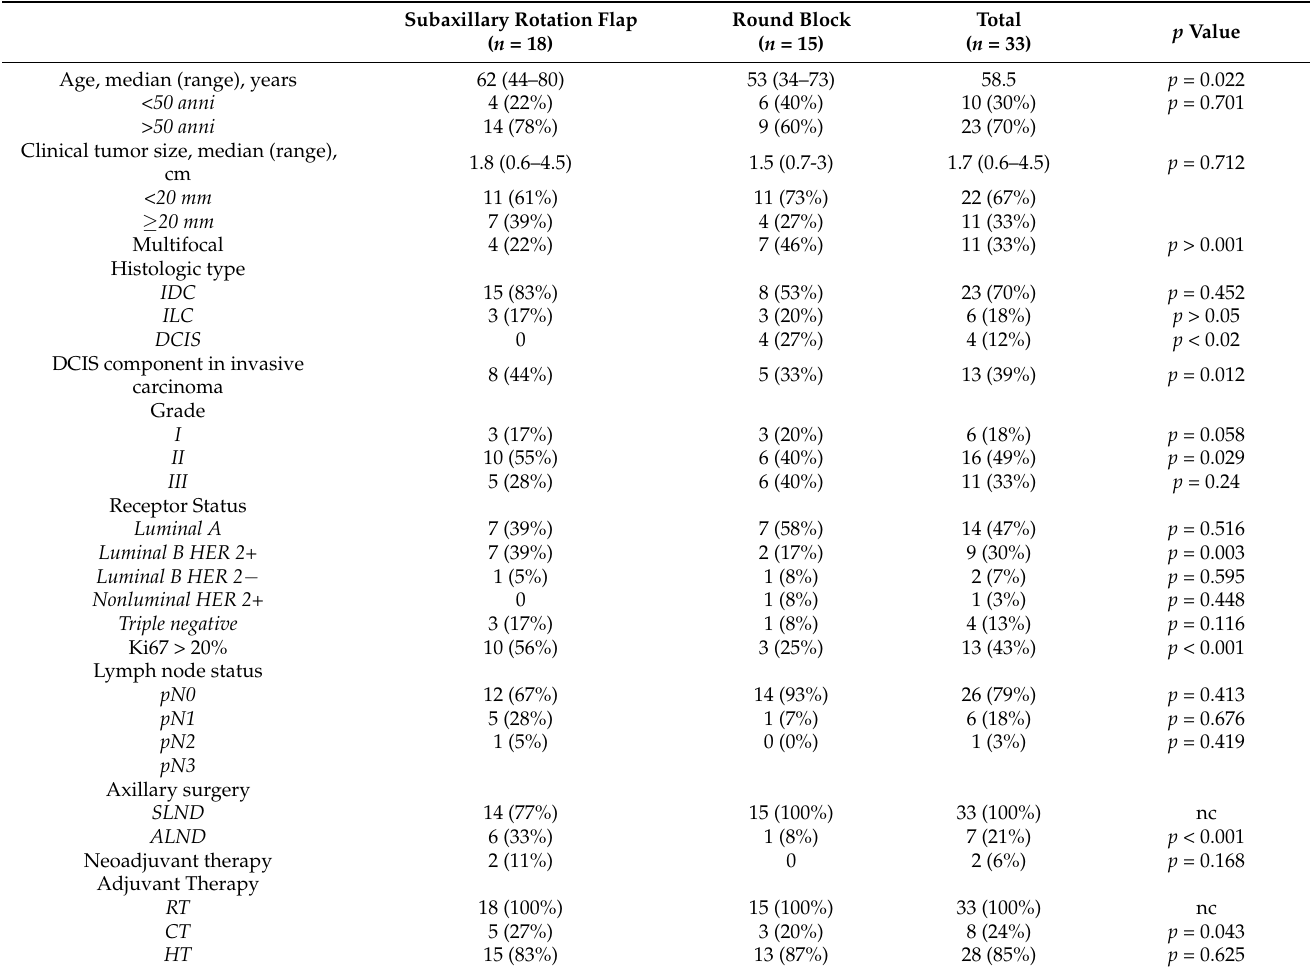
Table 1. Patient demographics and baseline